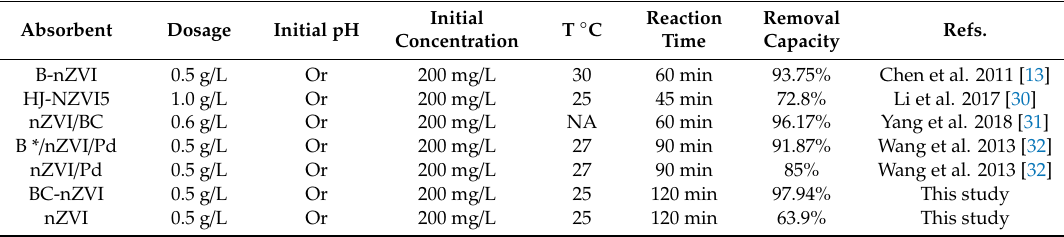
Table 1. Comparison of MO removal with different absorbents reported in literature.